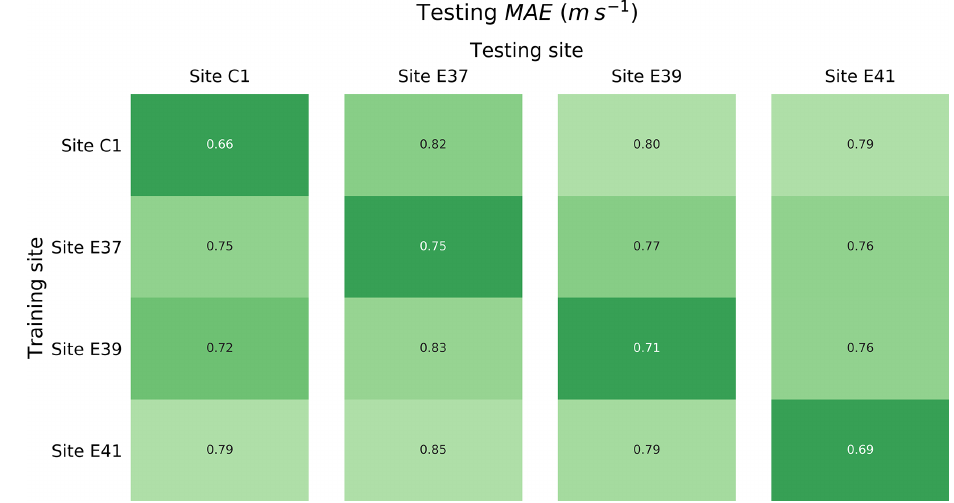
Figure 2. Testing mean absolute error (MAE) in predicting 30min average wind speed at 143ma.g.l. for the different sites, as a function of the site used to train the random forest.